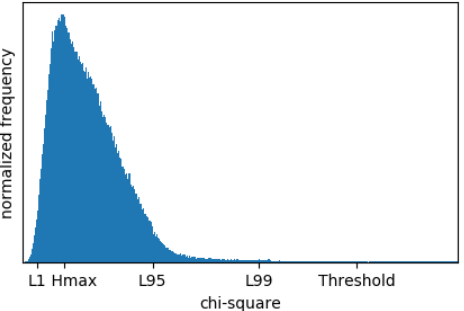
Figure 22. Example of chi-square distribution and considered sta- tistical levels.